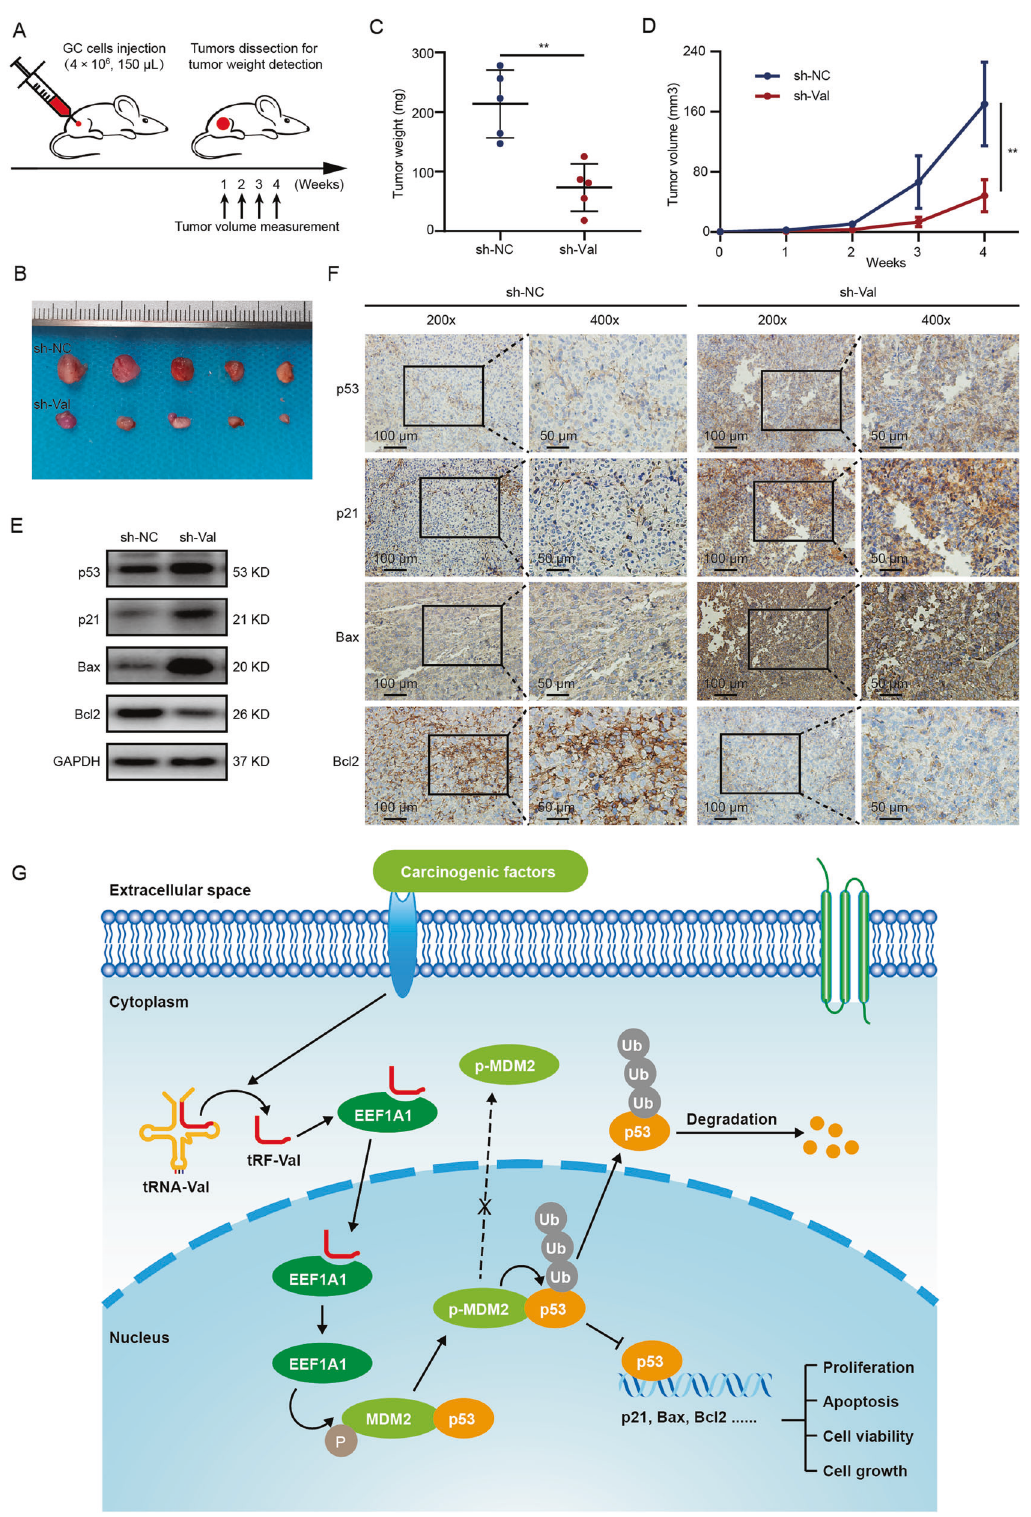
Fig. 7 Knockdown of tRF-Val inhibits the growth of GC in vivo. A The work fl ow of subcutaneous tumorigenesis. B The tumors of nude mice were dissected at 4 weeks after AGS cells injection in sh-NC and sh-Val groups ( n = 5 mice per group). C , D The weights and volumes of the tumors were signi fi cantly decreased in the sh-Val group than those in the sh-NC group. E , F The WB and IHC results indicated that expressions of p53, p21, and Bax were upregulated, while that expression of Bcl2 was downregulated in the sh-Val group. The scale bar, 100 μ m (200×); 50 μ m (400×). G The schematic diagram of the mechanisms that tRF-Val directly bound to EEF1A1, mediated its entry into the nucleus and promoted its binding with MDM2, thus inhibited the downstream molecular pathway of p53 and promote GC progression. Data were shown as mean ± SD. (Student ’ s t -test, ** P < 0.01).